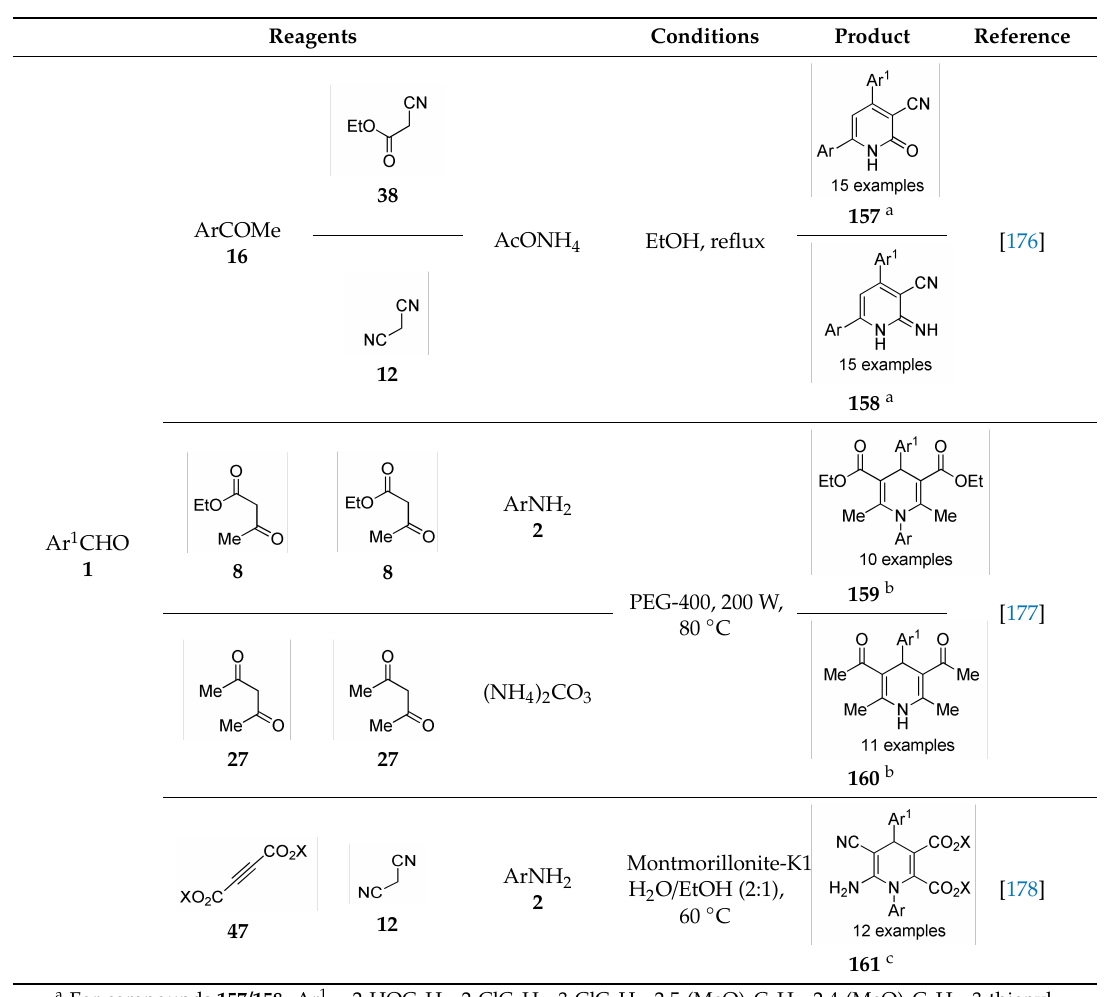
Table 2. Multicomponent synthesis of dihydropyridine-based heterocyclic systems 157 – 161 of potential anticancer